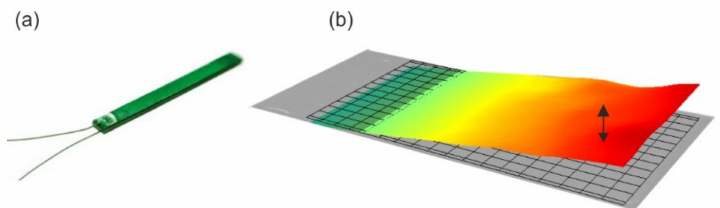
Figure 1. ( a ) Micrograph of the (lead zirconate titanate) PZT actuator, ( b ) optically measured modal shape (20-mode) with a laser Doppler